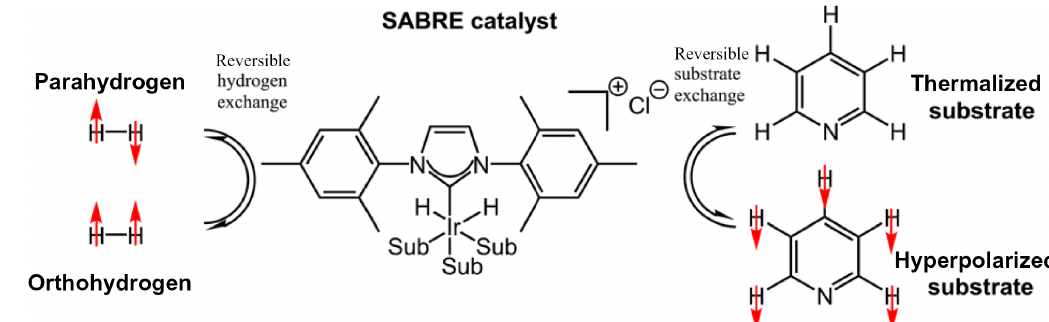
FIG. 7. Reversible hydrogen exchange that leads to hyperpolarization buildup on the free molecular substrate in solution. Left: free (unbound) hydrogen in solution. Center: SABRE active spin-order transfer catalyst. Right: free (unbound) substrate in solution. Steady- state excess of parahydrogen in the sample solution, maintained by periodic bubbling, leads to steady-state excess of hyperpolarized free substrate (Sub).